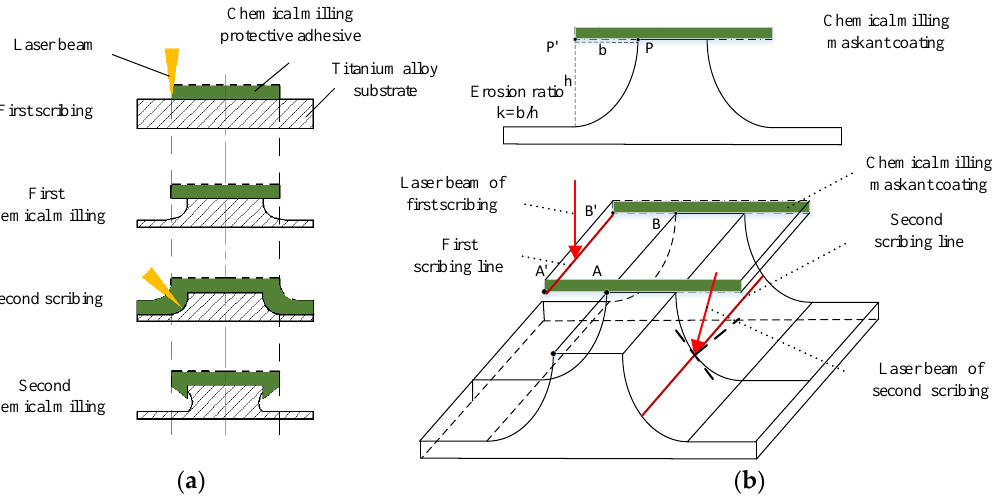
Figure 2. Section diagram of laser scribing. ( a ) Schematic diagram of stiffener for laser scribing; ( b ) Schematic diagram of twice laser scribing.